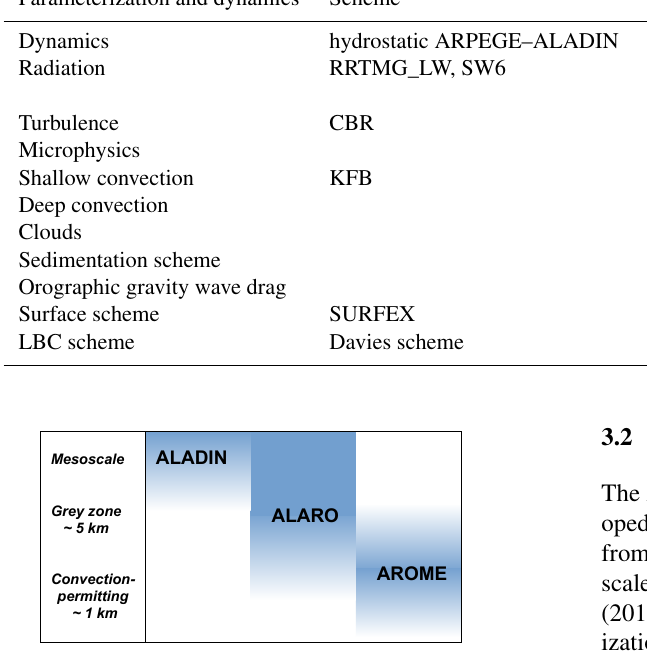
Figure 2. The different LAM configurations of the ALADIN Sys- tem and their target